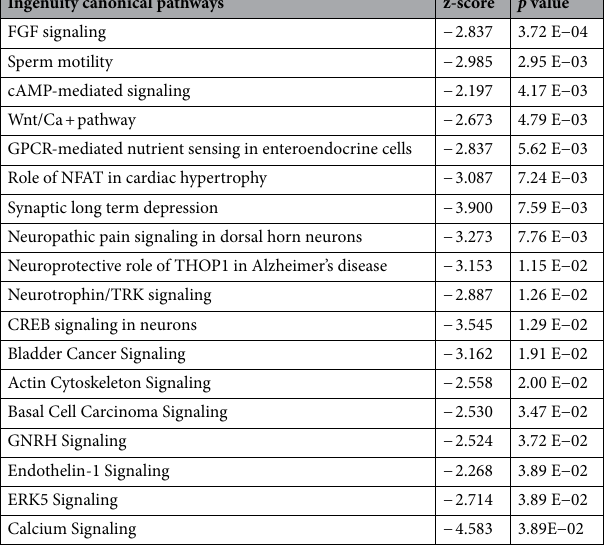
Table 4. Canonical pathways significantly over-represented among downregulated genes in control old versus young male mice under basal (no irradiation) conditions as assessed by Ingenuity Pathway Analysis. Benjamini-corrected p value < 0.05 and |z|≥ 2 was considered